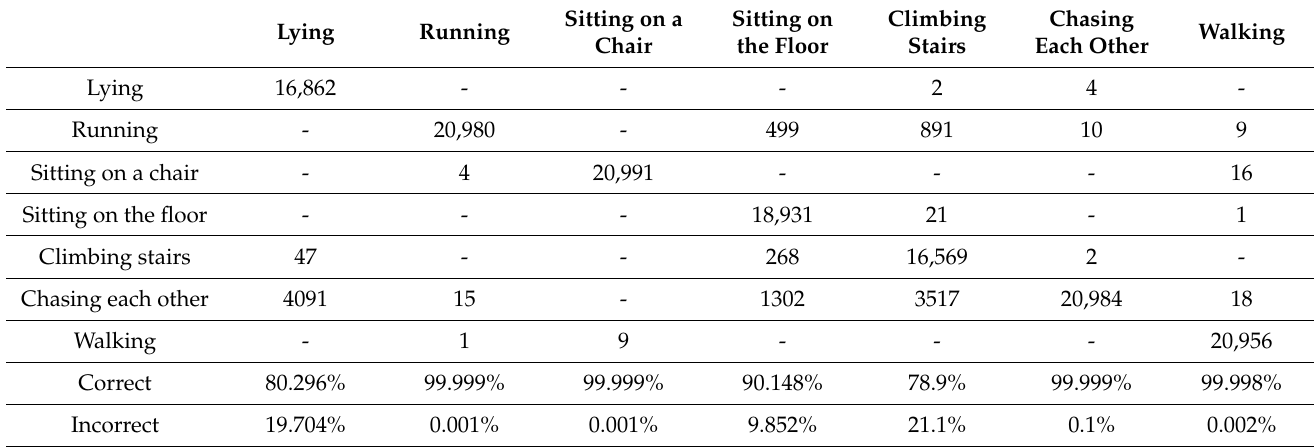
Table 5. Confusion matrix for 200 hidden units and 900